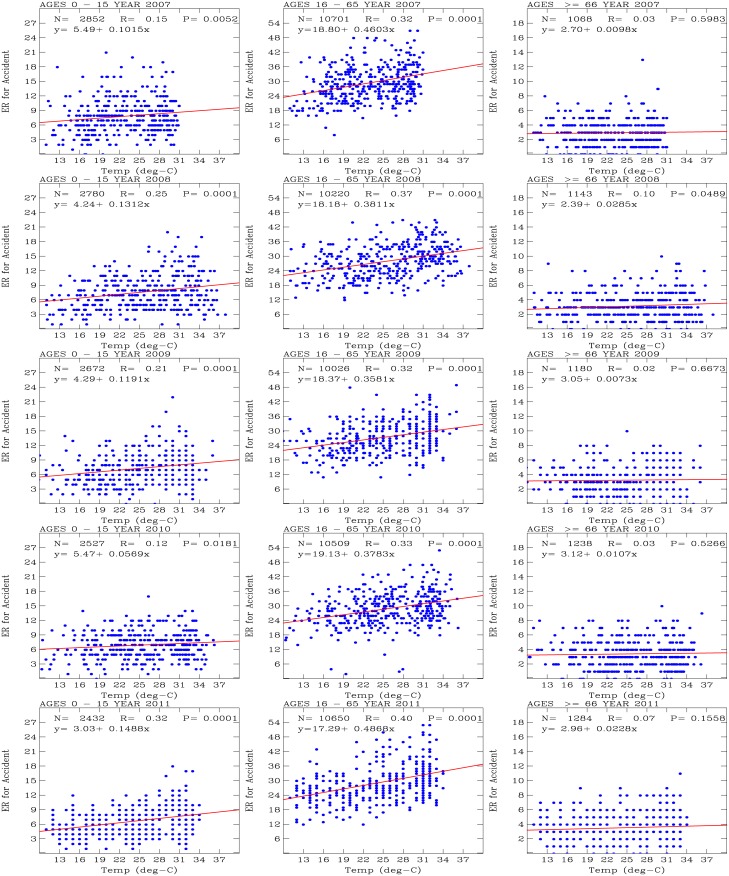
Scatter plots of number of daily emergency visits for accidents (y-axis) versus temperature (x-axis).The 3 age groups of outpatients are shown in the left (0–15 years old), middle (16–65 years old), and right (greater than 66 years old) panels; the years are arranged from top (2007) to bottom (2011). Red lines indicate the results of univariate regression performed on the data, with sample number N, correlation coefficient R, and measure of correlation significance P.